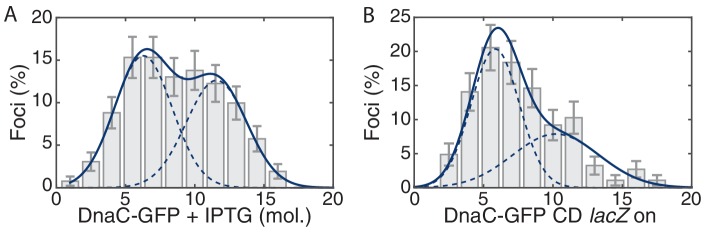
Control for head-on conflict experiment.(A) The observed stoichiometry of DnaC-GFP was not significantly altered by the addition of IPTG. Compare to Figure 1D. (B) Addition of lacZ (transcription on) in the co-directional orientation causes a small decrease to replisome stability.